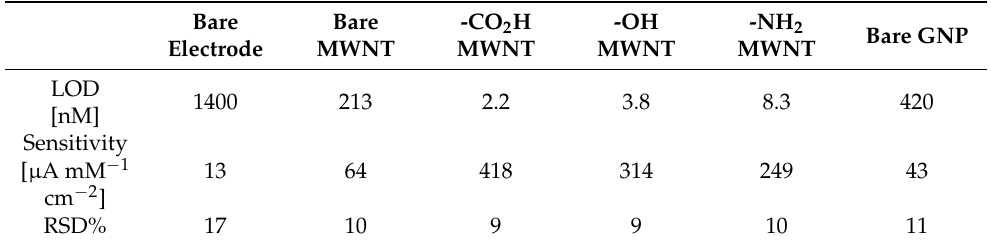
Table 4. LOD, sensitivity and reproducibility estimated for bare and CNMs-modified biosensor in urine matrix. These analytical parameters are obtained from chronoamperometric traces (E, time interval and time run respectively equal to 0.05 V, 0.01 s, and 300.0 s).